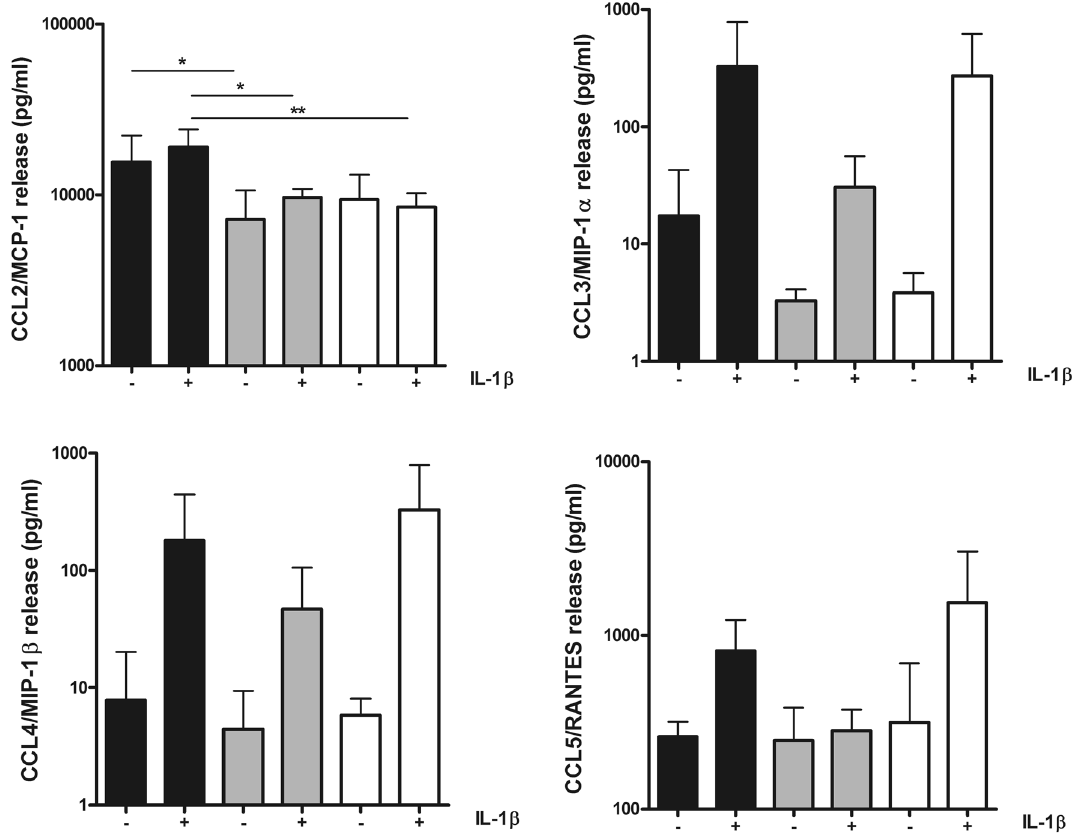
Figure 2. IKK dependency of the release of monocyte recruiting chemokines. Supernatants obtained from high density cultures of GL2 (black pattern), IKKαKD (gray pattern) or IKKβKD (white pattern) chondrocytes in control condition (−) or after IL-1β stimulation (24 h, +) were collected and assessed for the level of CCL2/ MCP-1, CCL3/MIP-1α, CCL4/MIP-1β and CCL5/RANTES. Data are reported as mean ± SD (n = 3 different experiments each performed with cells of different patients). The means of the groups were compared by ANOVA, followed by Tukey’s post hoc test. The differences were considered significant when p < 0.05 with *p < 0.05; **p <